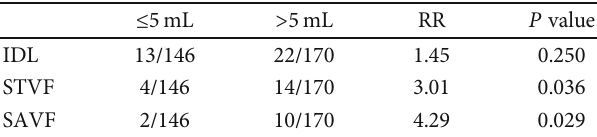
Table 3: The IDL, STVF, and SAVF in respective groups with di ff erent volumes of cement.